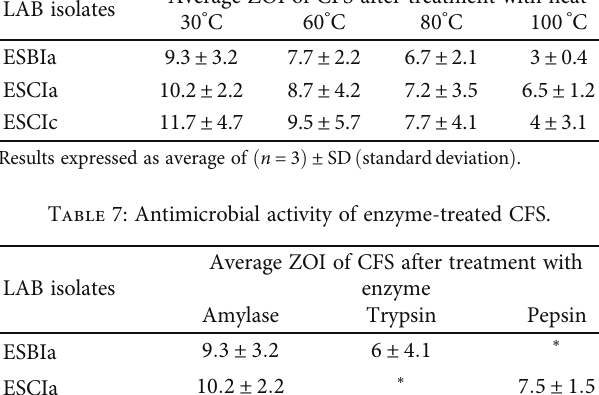
Figure 7: Evaluation of AMA of CFS of LAB isolates against S. aureus (A, B, C, D, and F), E. coli (E), and Salmonella spp. (G). Arrows indicate zones of inhibition. The numbers such as 1, 2, 3, and 4 show the representative LAB isolates with di ff erent sizes of zones of inhibition. Table 6: Antimicrobial activity of heat-treated CFS. LAB isolates